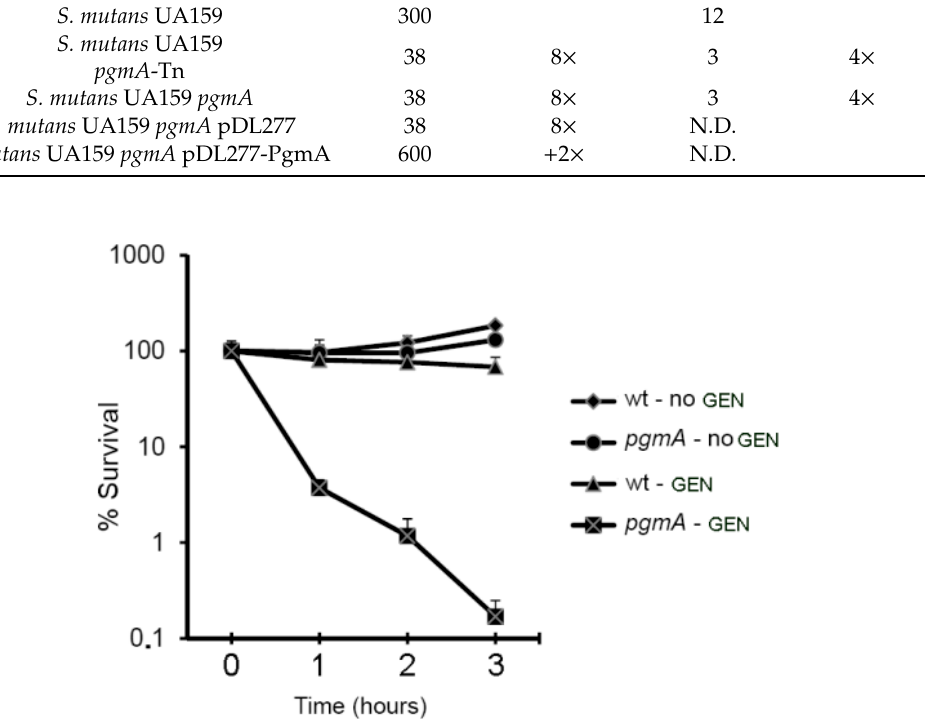
Figure 1. Gentamicin time-kill assay performed on biofilms of the S. mutans wild type and pgmA mutant. The data are averages of three replicates. Bars indicate standard deviations.